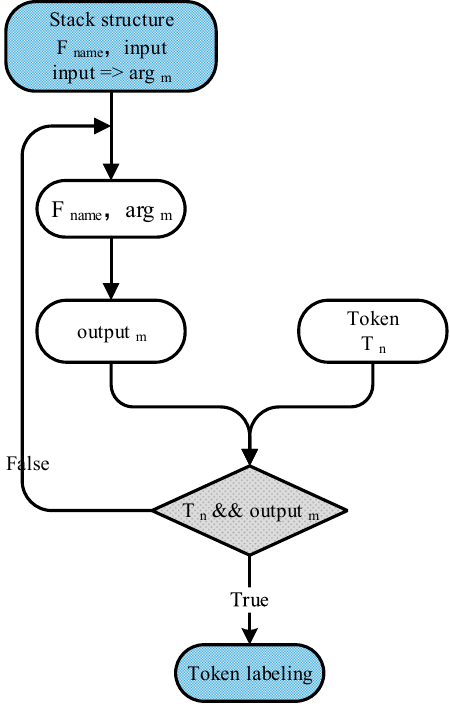
Figure 17. Token location module.